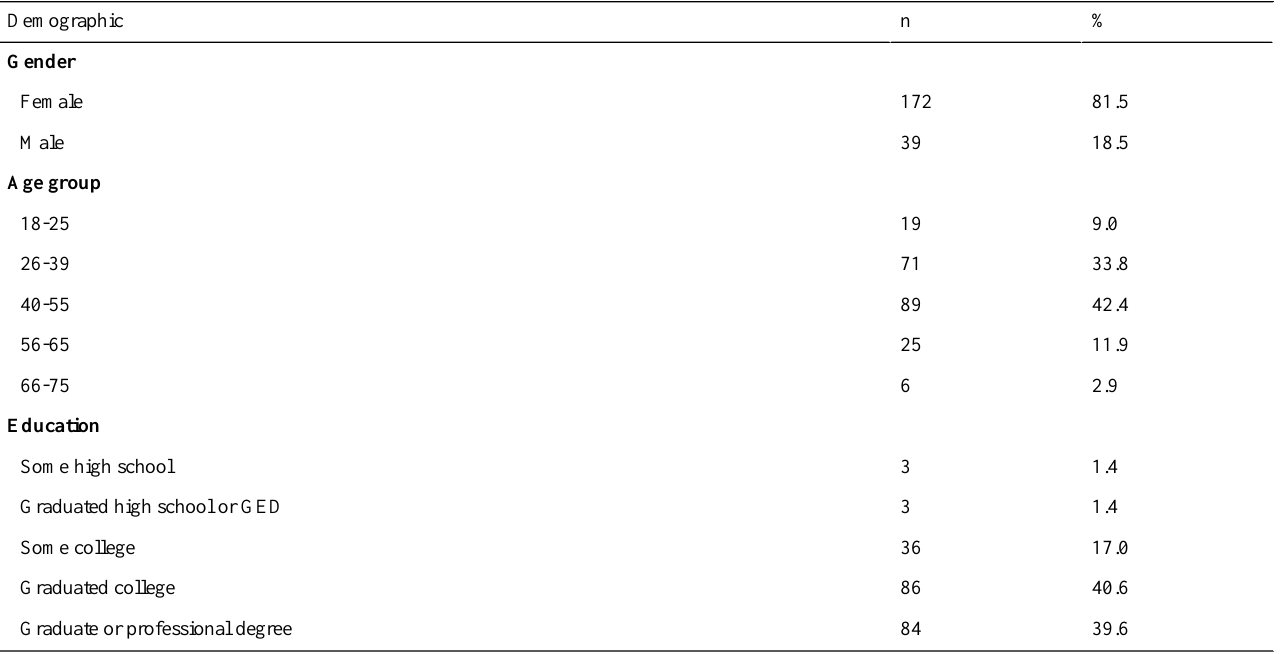
Table 1. Demographics of the survey participants (N =